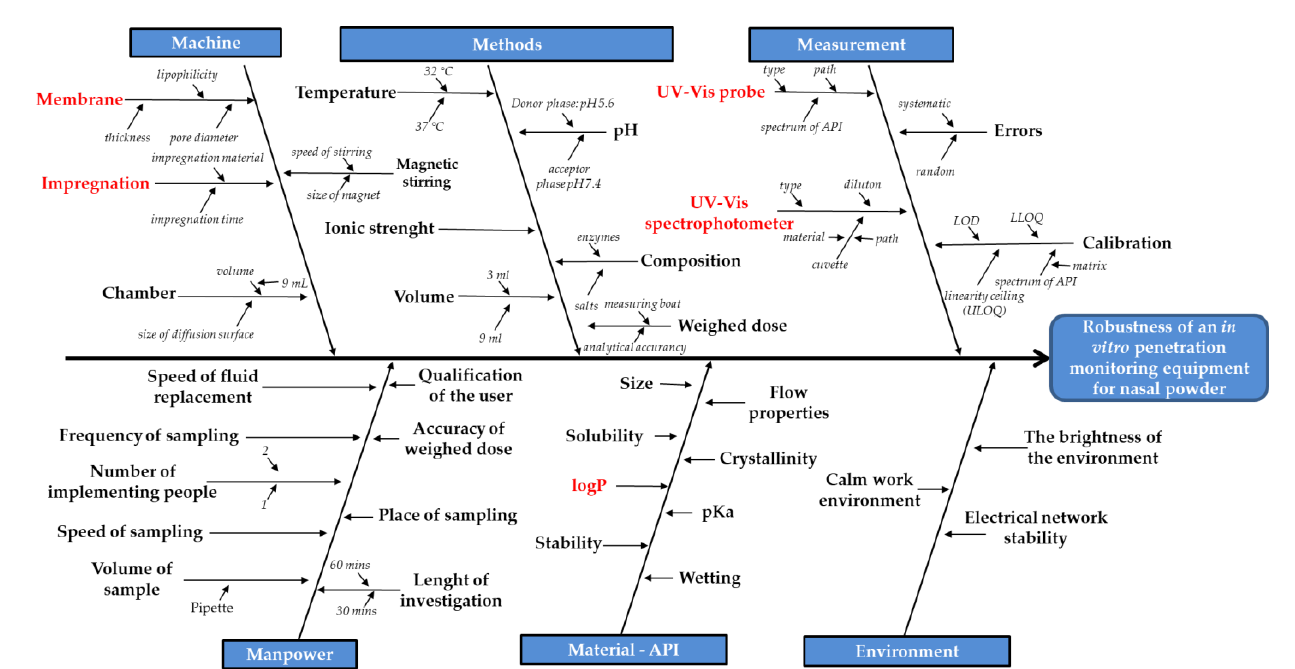
Figure 3. Ishikawa diagram of developing a system for in vitro penetration measurements of nasal powders, the most influencing factors are highlighted in red.